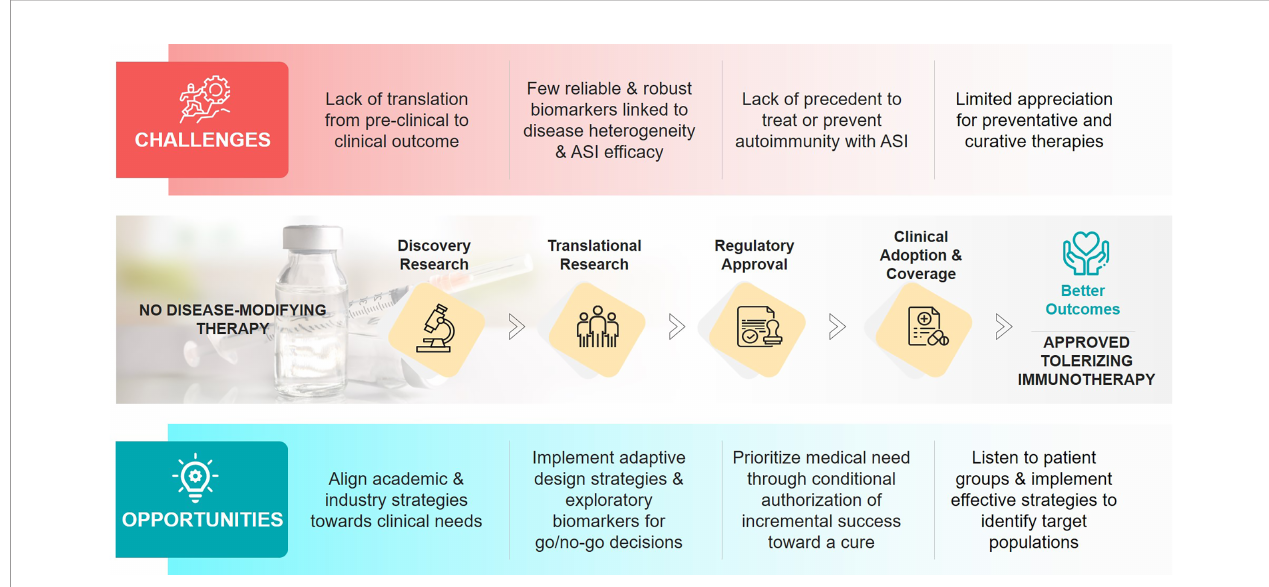
FIGURE 1 | Challenges and opportunities in the development of antigen-speci fi c immunotherapies (ASIs) for